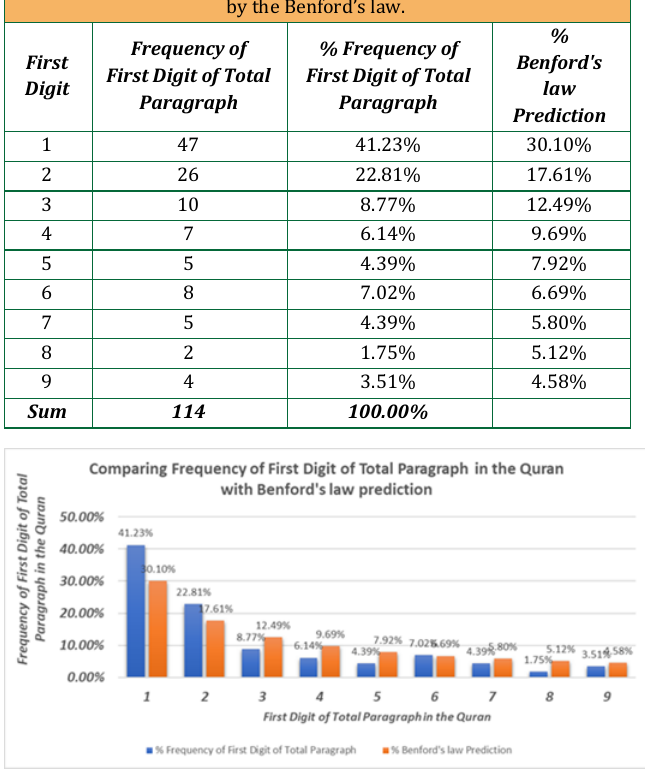
Figure 2: This chart shows frequency percentage of first digit of total paragraph in the Quran and frequency percentage of first digit predicted by the Benford’s